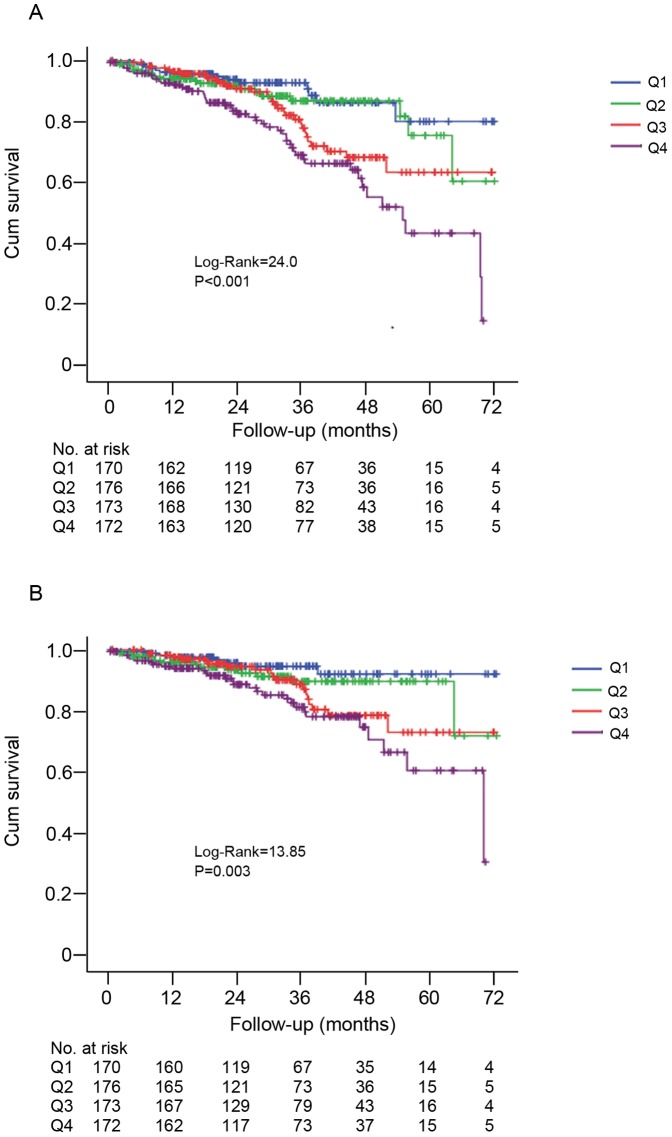
Kaplan-Meier survival curves for mortality according to serum potassium variability.(A) all-cause mortality; (B) cardiovascular mortality. Patients were split into four categories according quartiles (Q) of coefficient of variation of serum potassium (CVSP): Q1: <7.5%; Q2∶7.5 to <12.0%; Q3∶12.0 to <16.7%; Q4: ≥16.7%. The P values refer to the significance of the log-rank test across quartiles.